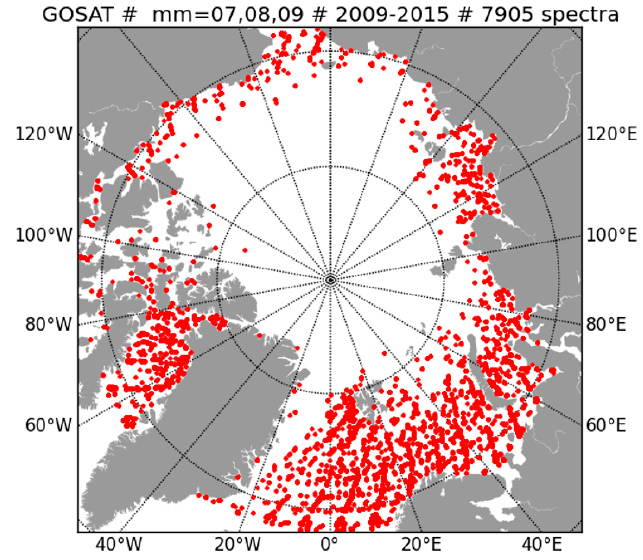
Figure 1. Plot of the footprint position of selected TANSO-FTS “clear, sea, normal lapse rate, good line contrast” for 2009 to 2015. Footprints are often superimposed due to the phased orbit of GOSAT.